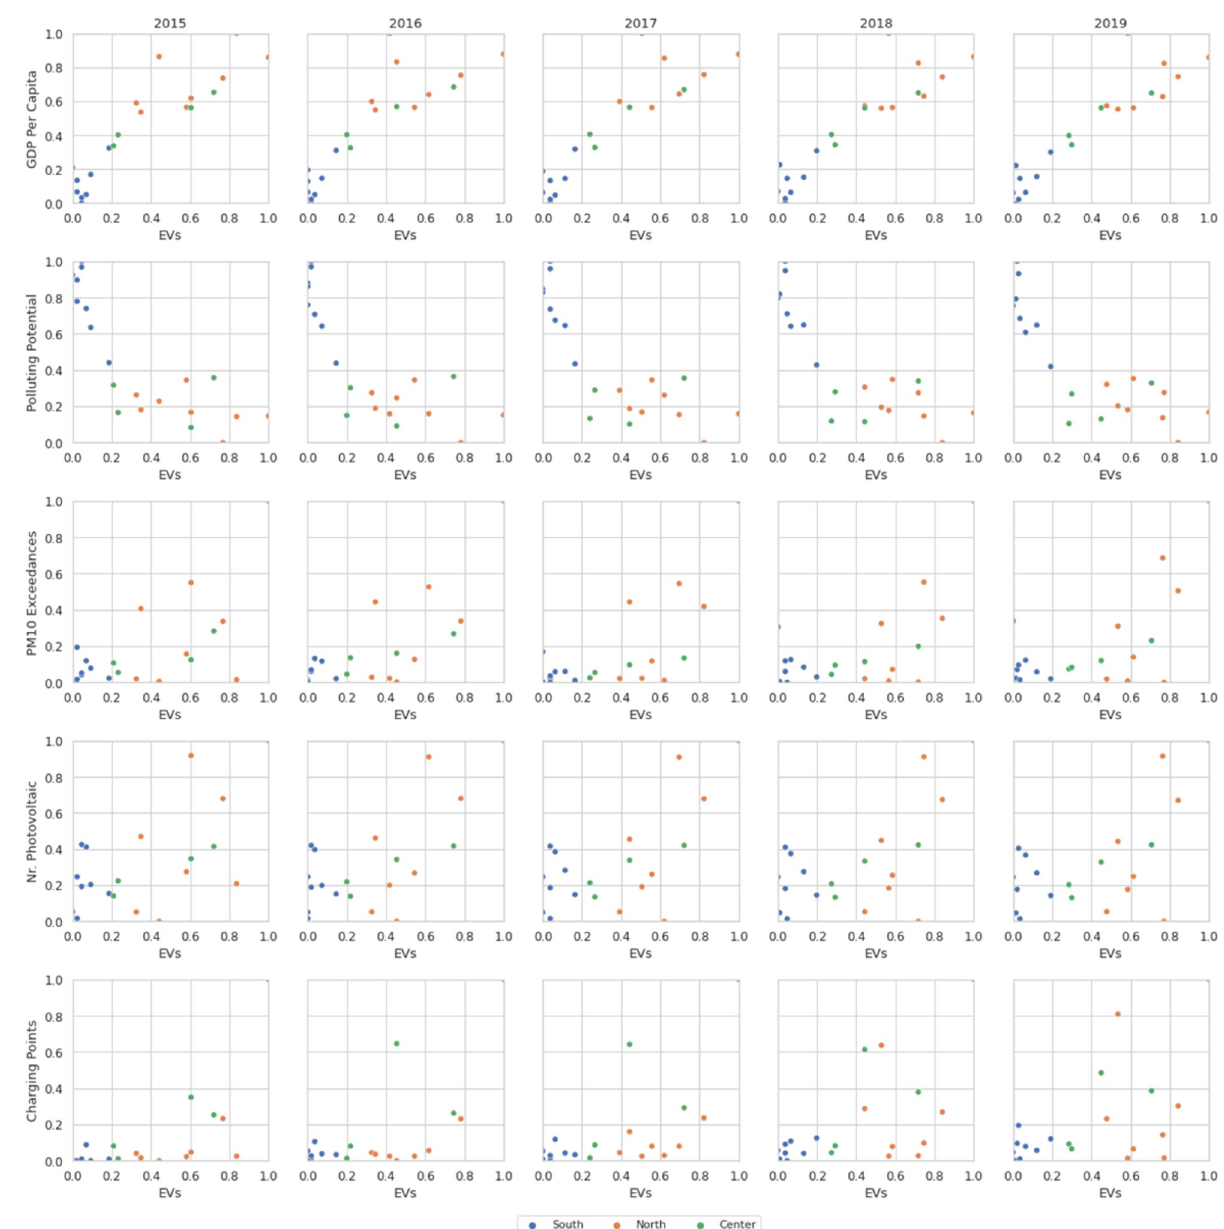
Fig 2. Scatter plot matrix with the target variable (regional percentage of EVs) of the following features: GDP Per Capita (PIL) , Polluting Potential , PM10 Exceedances , Number of Photovoltaic Panels and Number of Charging Points